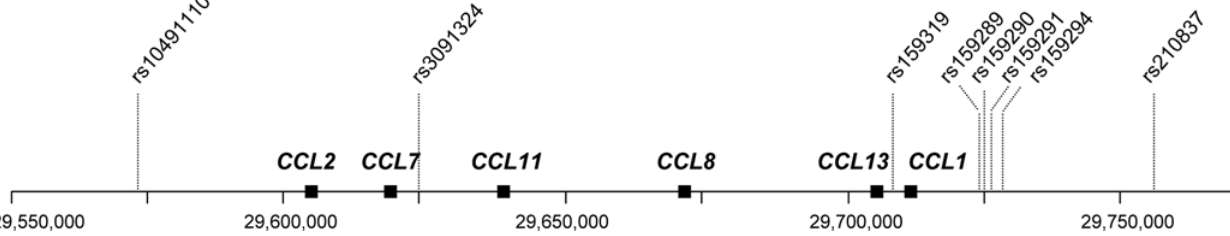
Figure 2. The CCL gene cluster containing CCL1 on chromosome 17. The black boxes denote the genes that are found in this region and the TB associated SNPs are approximately located by the dashed lines. *denotes gene encoding a hypothetical protein. Not to scale.